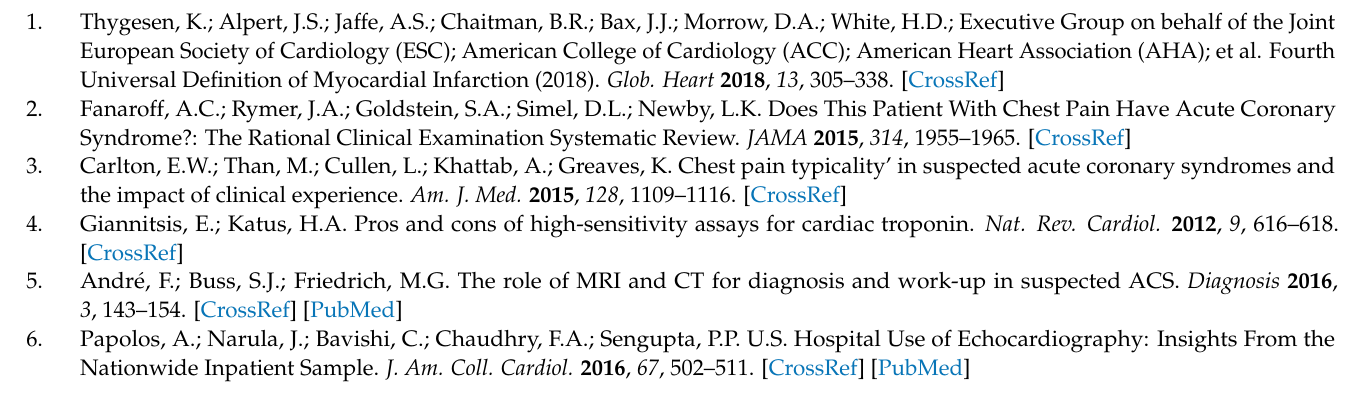
Figure S2: (A) ROC comparison of discriminatory ability of copeptin, hs-cTnT at 0 h and hs-cTnT at 3 h at validation cohort. (B) ROC comparison of discriminatory ability of hs-cTnT as maximal concentration and concentration change at validation cohort; Figure S3A: Kaplan–Meier curves, copeptin ≤ 45 vs. >45 pmol/L by all-cause death at 365 days title; Figure S3B: Kaplan–Meier curves, hs-cTnT at 0 h ≤ 74 vs. >74 ng/L by all-cause death at 365 days; Figure S3C: Kaplan–Meier curves, hs-cTnT at 3 h ≤ 78 vs. >78 ng/L by all-cause death at 365 days; Table S1: Baseline characteristics and laboratory values in validation cohort; Table S2: Cox regression models in validation